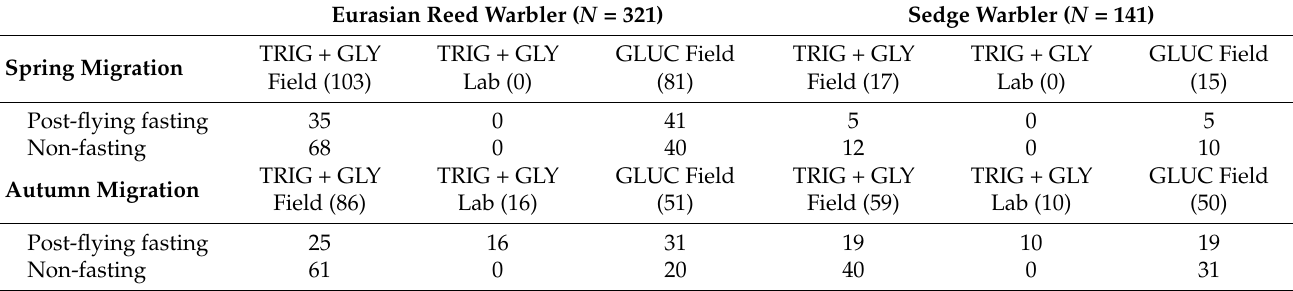
Table 1. Sample size of birds captured during spring (15 March 2011–15 October 2012) and autumn migratory seasons (1 August–15 October of 2011, 2012 and 2014) and the number of birds captured with and without playback (Tape lure = Post-flight fasting birds, non-tape lure = Non-fasting birds). Eurasian Reed Warbler ( N = 321) Sedge Warbler ( N =